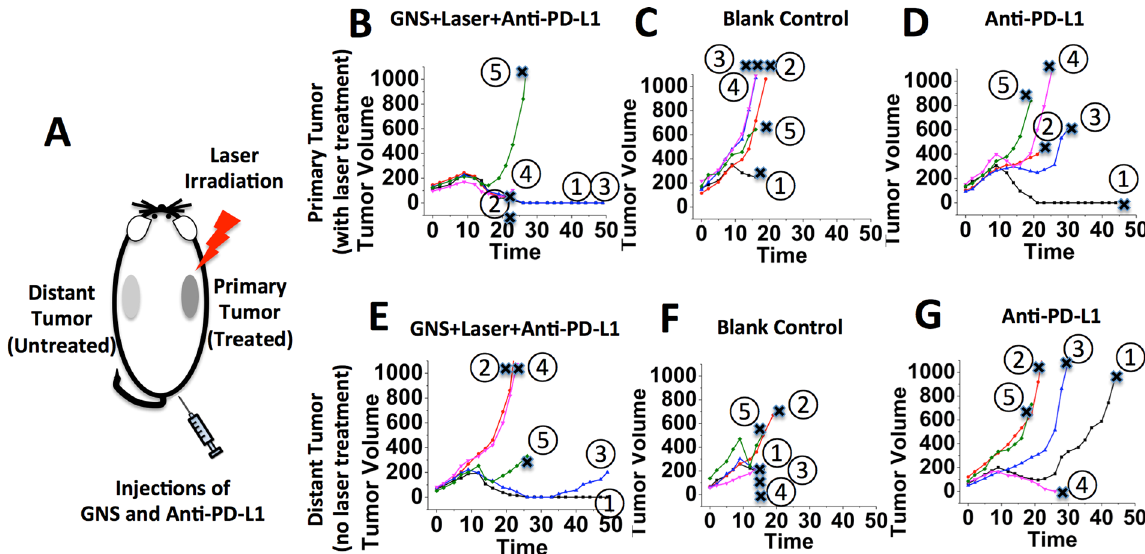
Figure 2. LEFT: ( A ) SYMPHONY treatment principle. The right flank tumor was treated photothermally and the left flank tumor not. RIGHT Top: Tumor growth for primary tumors in the SYMPHONY group (GNS + Laser + Anti-PD-L1) ( B ), in the control group ( C ), and in the group with anti-PD-L1 alone ( D ). RIGHT Bottom: Tumor growth for distant tumors in the SYMPHONY group (GNS + Laser + Anti-PD-L1) ( E ), in the control group ( F ), and in the group with anti-PD-L1 alone ( G ). The laser irradiation of photothermal therapy was performed only on the primary tumors. The line stopped ( × sign in black color) if the mouse was sacrificed. The tumor volume unit is mm 3 and the time unit is day.